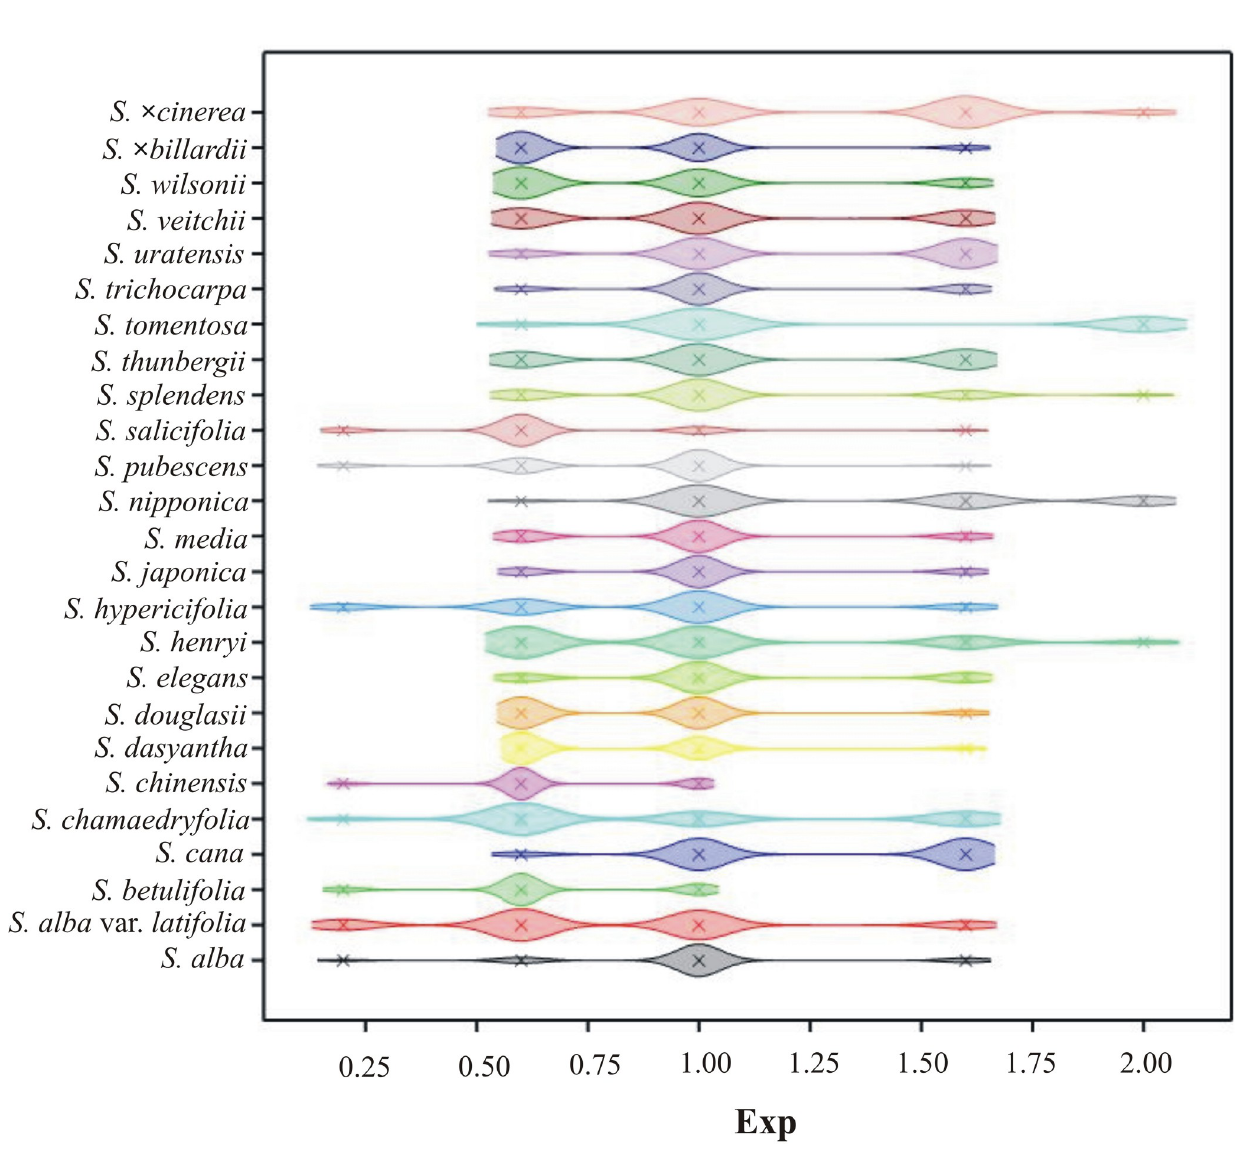
Fig 8. The density plot of Exp by Spiraea